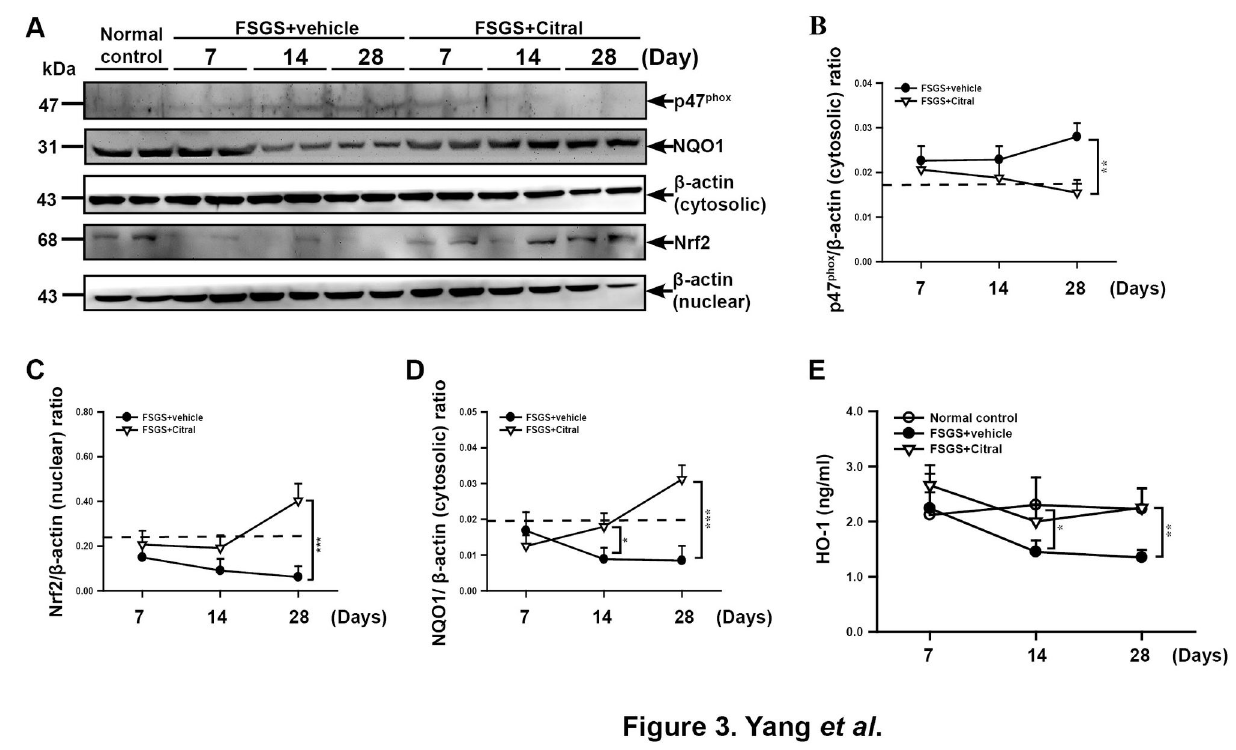
Figure 3. Renal nuclear Nrf2 levels, cytosolic p47 phox , NQO1 and HO-1 levels. (A) Representative Western blot showing levels of cytosolic p47 phox and NQO1 and nuclear Nrf2 in kidney tissues. (B-D) Quantification of the p47 phox /β-actin (cytosolic) ratio (B), the Nrf2/β-actin (nuclear) ratio (C), and the NQO1/β-actin (cytosolic) ratio (D). The horizontal dashed lines indicate levels in normal control mice. (E) HO-1 levels in the kidney. In B-E, the data are the mean±SEM for seven mice per group. * p < 0.05, ** p < 0.01, *** p < 0.005. doi: